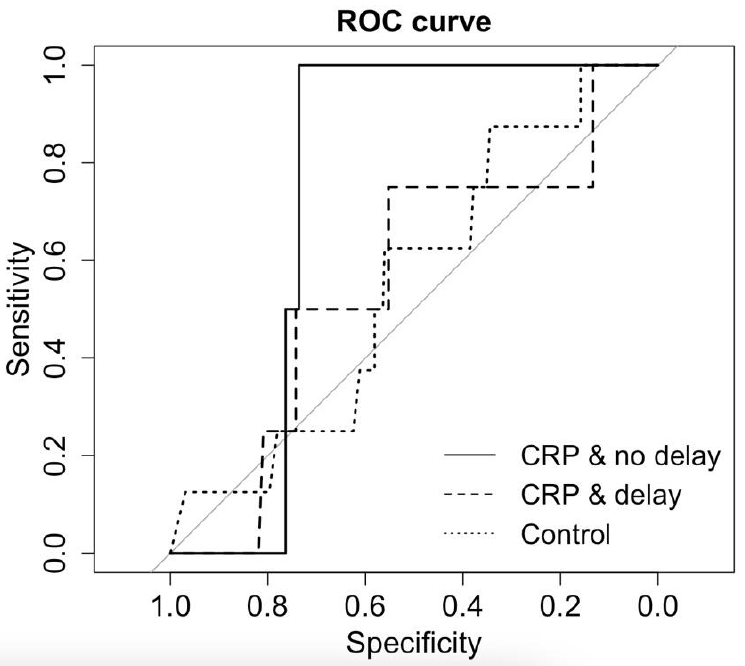
Figure 1. Joint confidence-region estimation for area under ROC curve and Youden index regarding serum CRP and PJI. serum CRP and